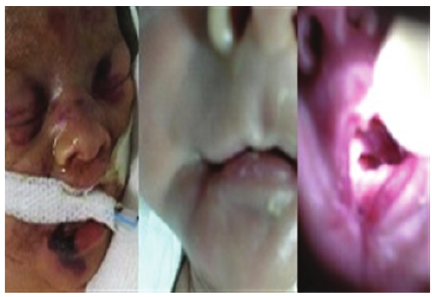
Figure 1: Appearance of necrotic ulcers in the edge of the lip at baseline and one month